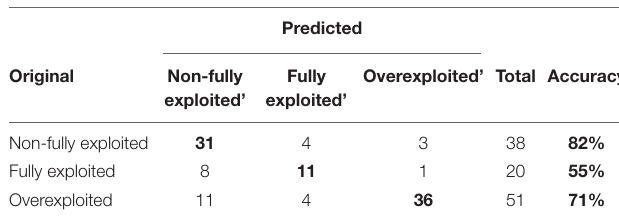
TABLE 3 | Correspondence between the original classification of the biomass status categories and the predicted categories obtained through the multinomial model with best fit (Biomass Status ∼ Economic_class + poly (HDI, 2) + Serranid richness), and the percentage of accuracy of the prediction model by biomass status